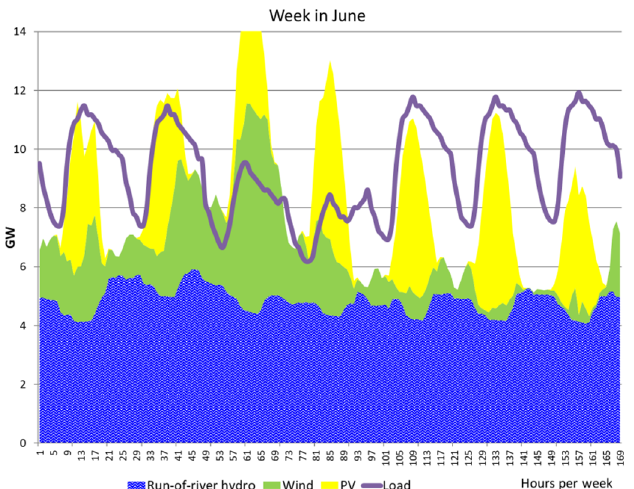
Fig. 8. Modeling variable renewable energy sources and, electricity load during a week in June 2030 in Austria (Source: own analysis, adapted from [3]).